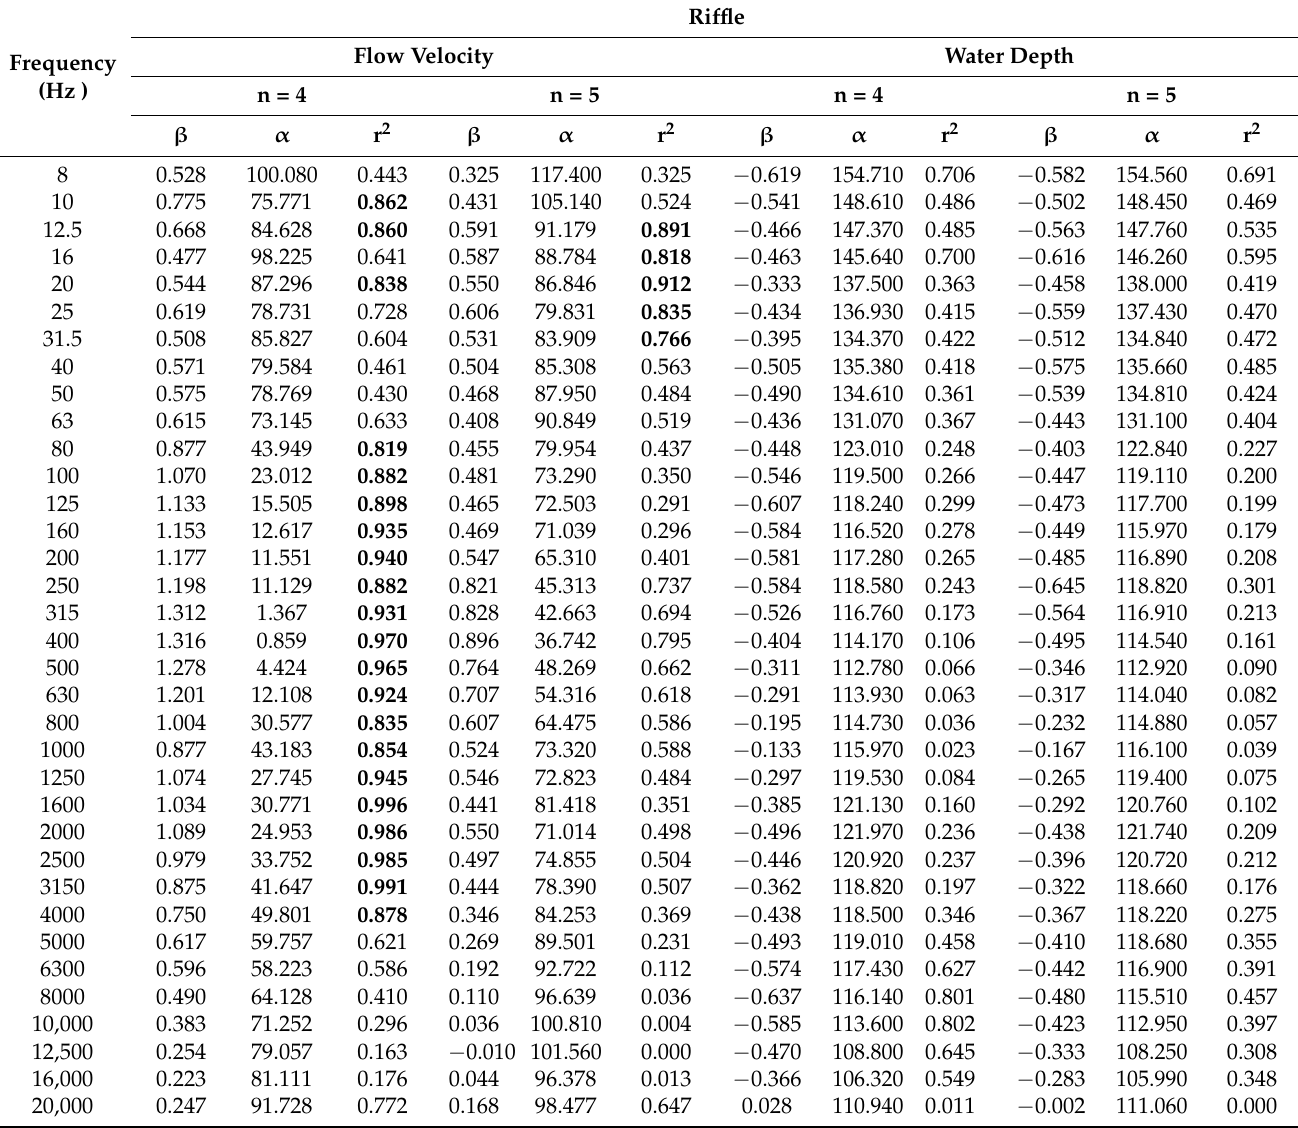
Table 3. The slope β , regression intersect α , and the determination coefficient r 2 of the linear regression for the relationship between underwater SPL(Y) and flow velocity/water depth(X) in the riffle. n = 5 is the number of spots, including all riffles, and n = 4 is except to H10 from